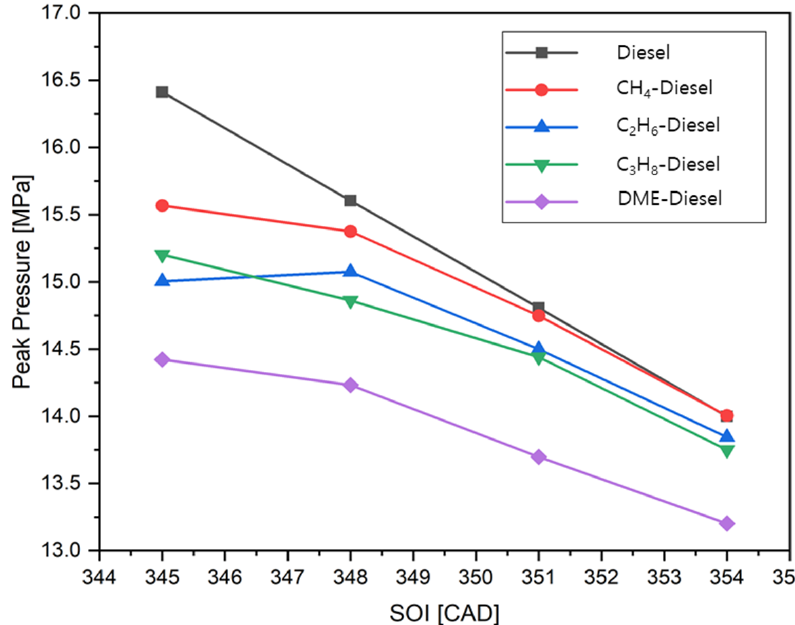
Figure 20. Maximum pressure according to pilot SOI angles in all combustion modes.